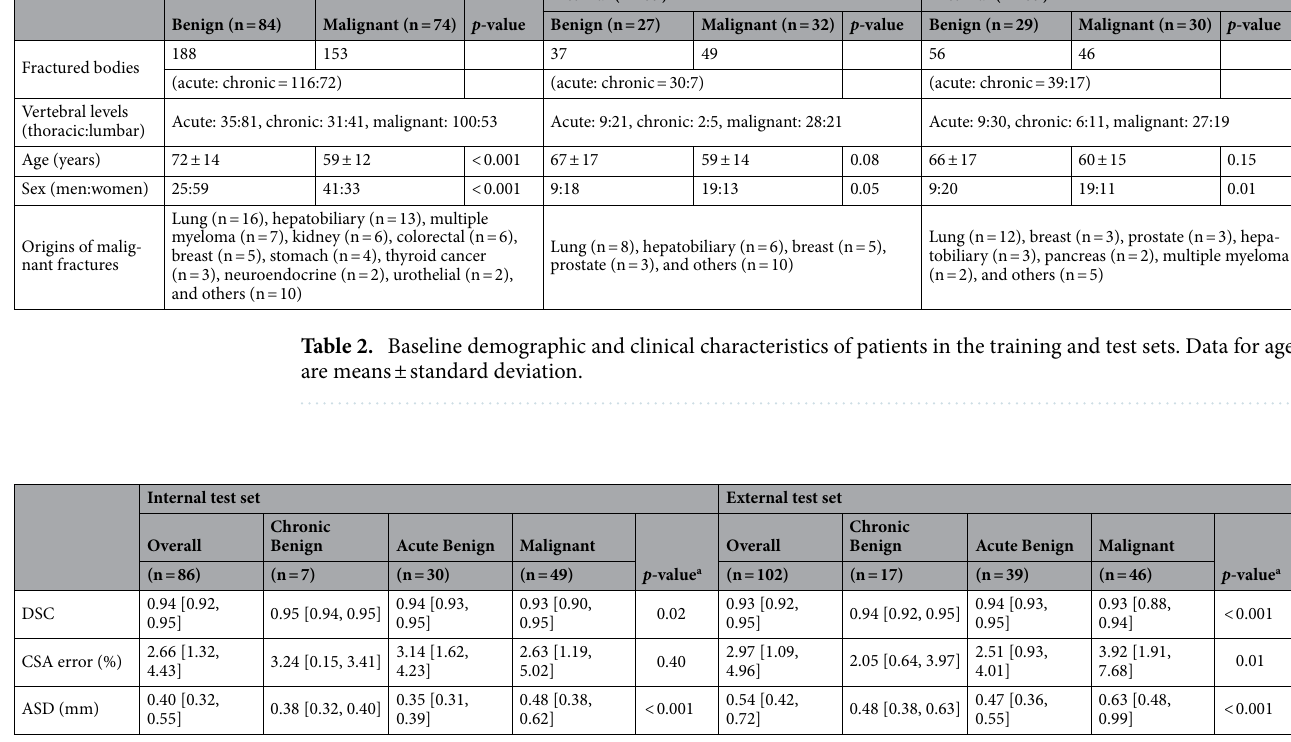
diomics features, 38 zero variance features and 175 unstable features with CCC > 0.90 from multiple observer segmentation were excluded, leaving 67 features for the subsequent analysis. Excluding one of the highly cor- related features further reduced these 67 features to 39 features. Finally, the LASSO regression model selected 12 features, and their non-zero coefficients were used to construct a radiomics model to predict the fracture malignancy (Table 4). Model performance. The radiomics model showed good discriminatory performance in the training set (AUC, 0.93 [95% CI, 0.90–0.97]). Using the cutoff threshold of 0.328, the model showed accuracy of 85% (134/158), sensitivity of 93% (69/74), specificity of 77% (65/84), PPV of 78% (69/88), and NPV of 93% (65/70). Comparison of automated and human expert segmentations. The diagnostic performances of the radiomics model in the test sets are shown in Table 5. Both the automated segmentation and the human expert segmenta- tion yielded good AUCs of 0.80–0.87 in the test sets. In the internal test set, human expert segmentation showed slightly higher AUC than the automated segmentation, although the difference was statistically significant